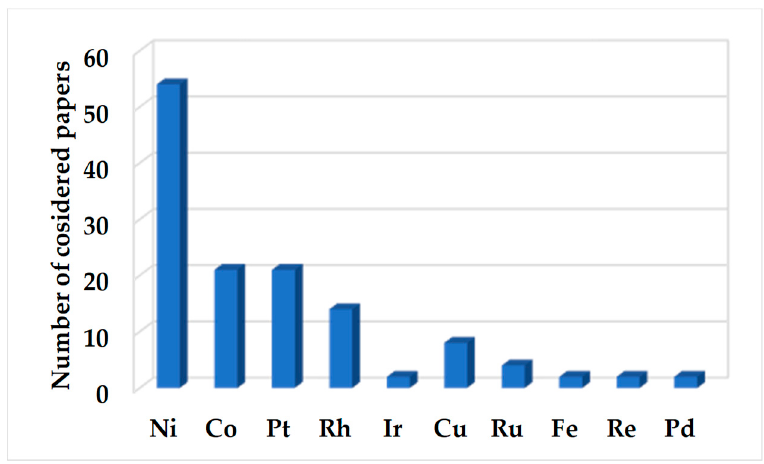
Figure 6. Number of considered papers as a function of the active phase analyzed for the ethanol